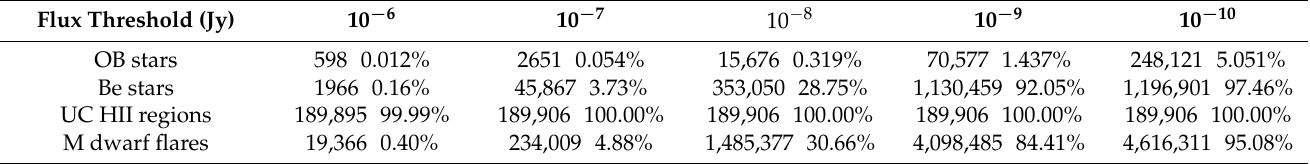
Table 1. The number of detectable sources and fractions they account for corresponding to different detection limits. Flux Threshold